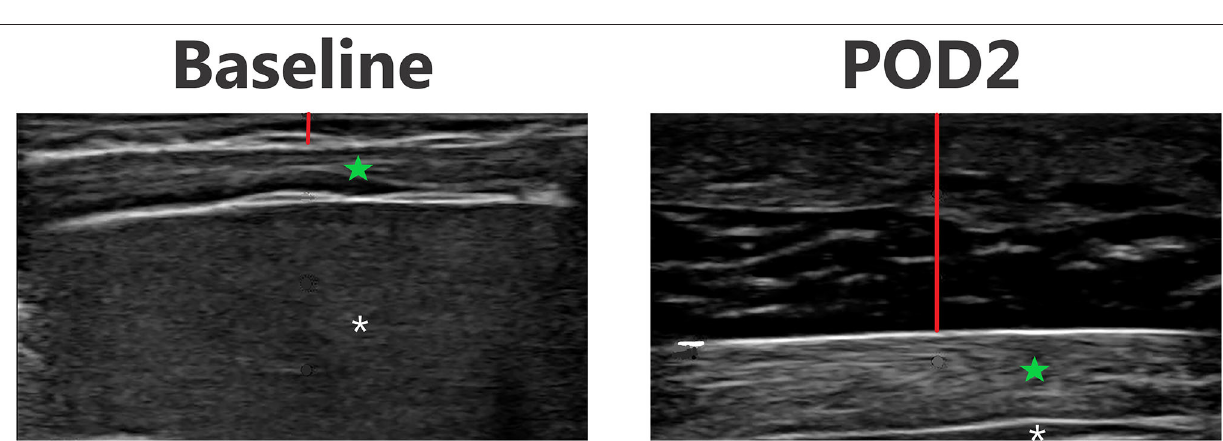
Figure 9 . Correlation between manual and automated baseline, measurements for right sided lateral abdomen and left sided anterior thigh of all subjects was strong ( Table 4